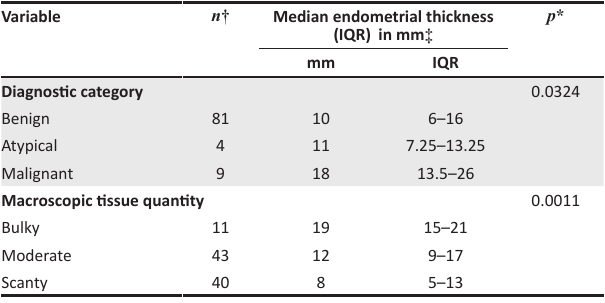
TABLE 3: Median endometrial thicknesses per diagnostic category and macroscopic quantity of tissue in postmenopausal women obtained by endometrial sample at Chris Hani Baragwanath Academic Hospital, South Africa, 01 July 2013 – 31 May